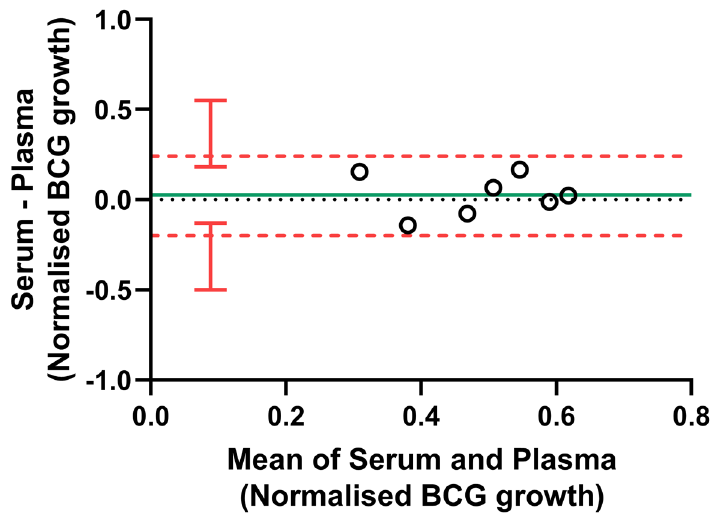
Figure 6. Bland-Altman plot comparing serum vs. plasma in the NHP direct MGIA. The NHP PBMC direct MGIA was conducted using either autologous serum or plasma for n=7 macaques. Co-cultures were performed in duplicate where sufficient numbers of cells were recovered. The solid green line indicates the mean difference between measurements and the dotted red line indicates the upper and lower limits of agreement (mean difference ± 1.96 standard deviation of the difference) with red vertical bars showing the 95% confidence intervals for the limits of